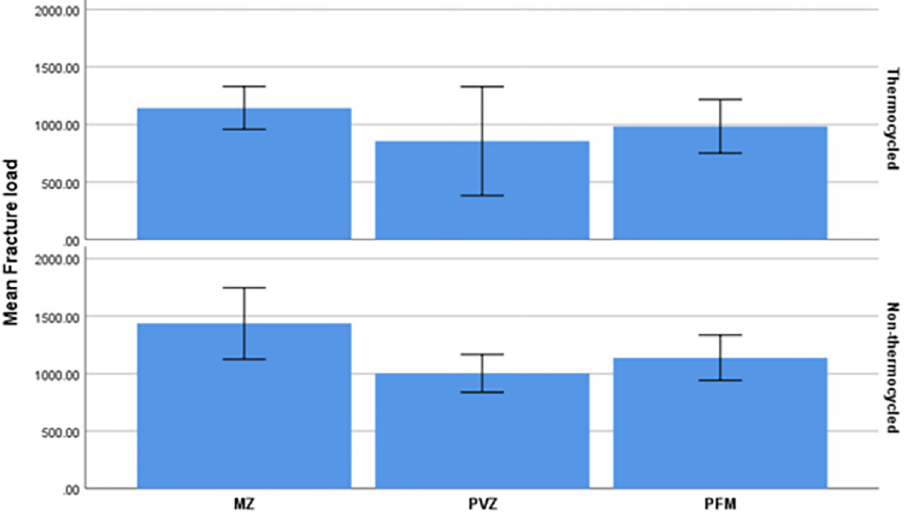
Fig 8. Pareto curve of MZ, PFM, and PVZ in thermocycled and non-thermocycled samples.